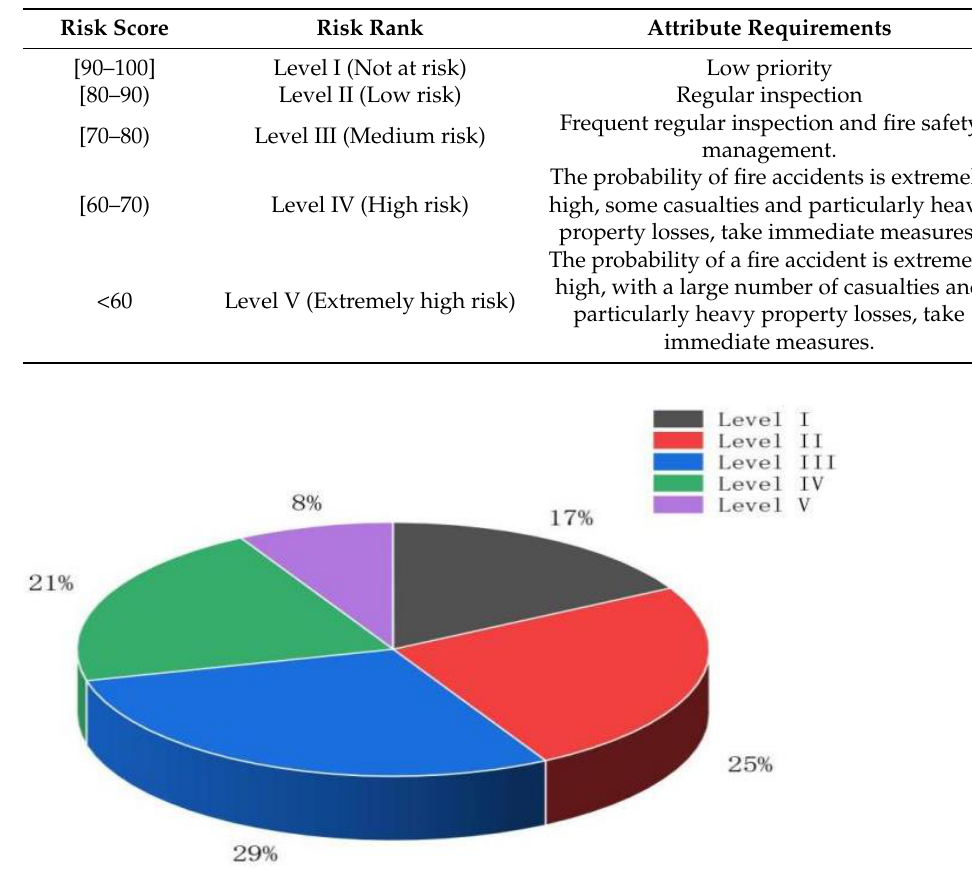
Table 1. Classification of fire risk ranks.